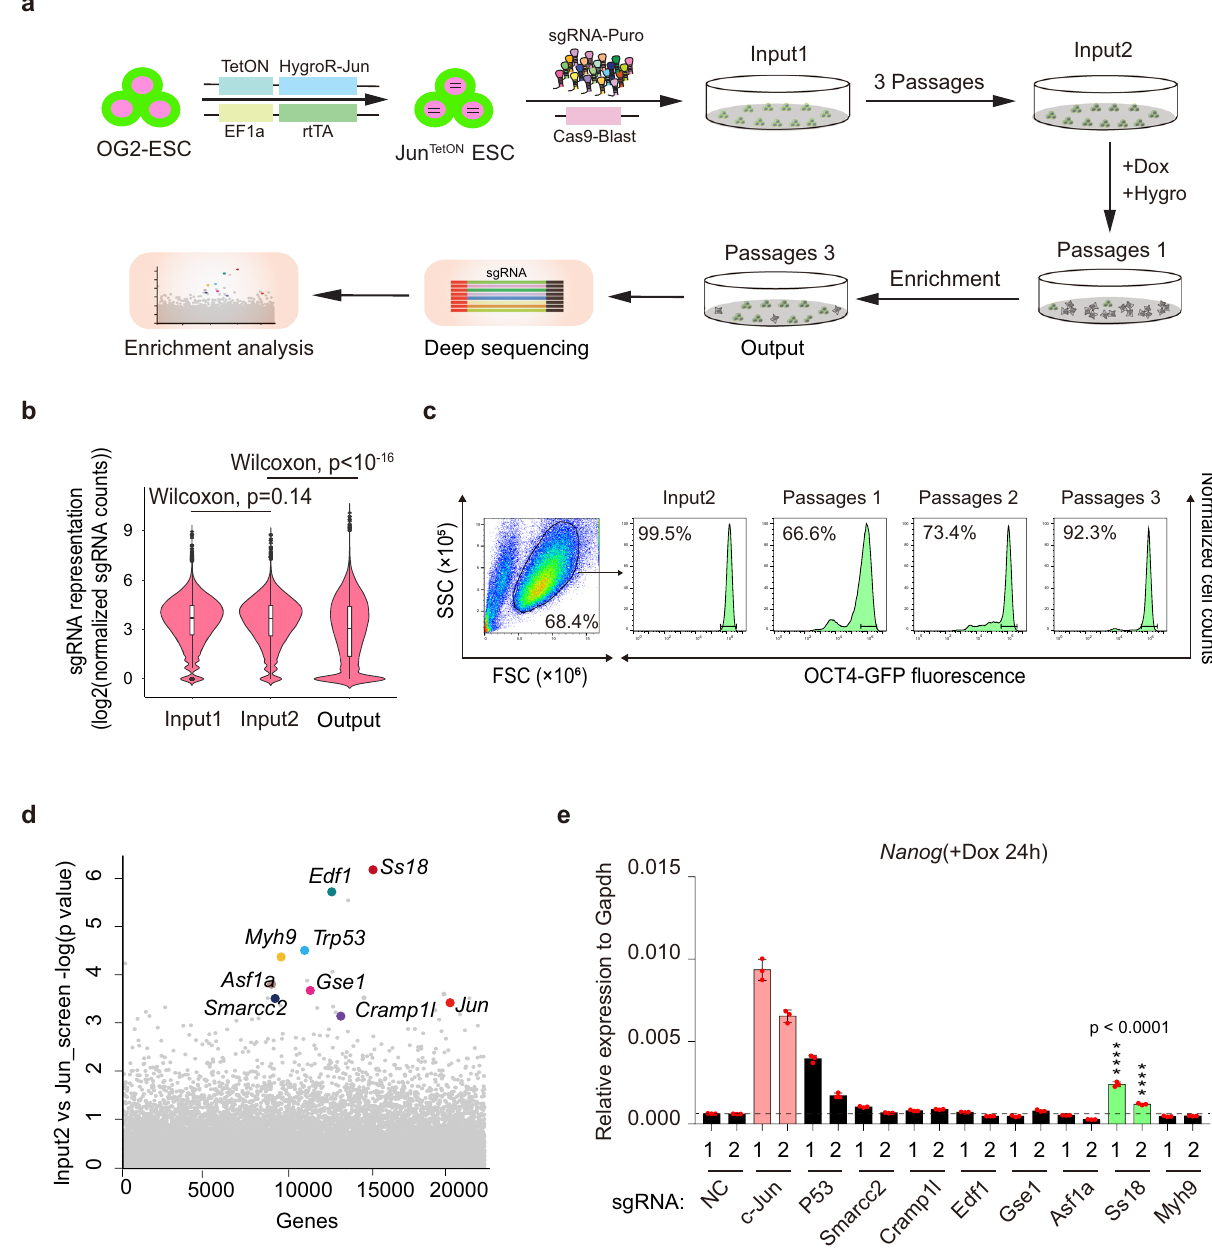
Fig. 1 Genome-wide screen for factors regulating PST. a The work fl ow for GeCKO screening strategy by HygroR-Jun TetON OG2ES. TetON cell line was successively infected with viruses expressing Cas9 and sgRNA. Dox and hygromycin were added after three cell passages. Dox and hygromycin were removed in 24 h and 48 h, respectively. Cells that survived after three passages were collected and analyzed. Hygro, hygromycin; HygroR, hygromycin resistance gene; GeCKO: Genome-wide CRISPR-Cas9 knockout. b Violin plot showing the distribution of sgRNA frequencies at different stages of screen. The distribution of sgRNA library was signi fi cantly polarized after the screening (output) compared to input 1 and input 2. Two-sided Wilcoxon test adjusted for multiple comparisons. n = 65959 sgRNAs. Input 1, Minimum 0, 25%Percentile 2.672, Median 3.693, 75%Percentile 4.452, Maximum 8.934; Input 2, Minimum 0, 25%Percentile 2.611, Median 3.672, 75%Percentile 4.456, Maximum 8.764; Output, Minimum 0, 25%Percentile 1.366, Median 3.064, 75%Percentile 4.391, Maximum 10.07. Two independent experiments. c Distribution of OG2-GFP signaling at different passages by FACS during this screening. d Identi fi cation of top candidate genes using the MAGeCK 43 algorithm. e Validation of the hits in ( d ) by corresponding sgRNAs within GeCKO library during c-JUN induced PST. Data are mean ± s.d., two-sided, unpaired t test; n = 3 independent experiments, **** p <